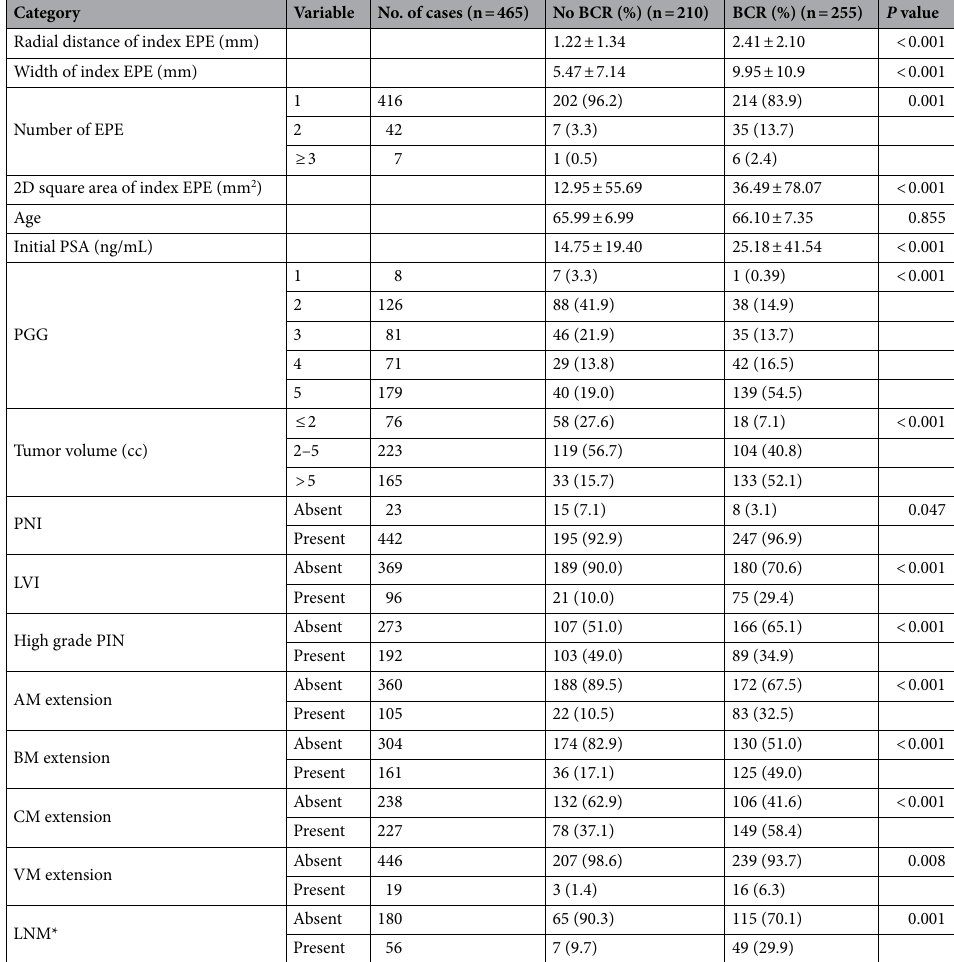
Table 1. Demographic results of 465 EPE positive pT3a cases according to BCR. BCR, biochemical recurrence; EPE, extraprostatic extension; PSA, prostate specific antigen; PGG, prostate grade group; PNI, perineural invasion; LVI, lymphovascular invasion; AM, apex margin; BM, basal margin; CM, circumferential margin; VM, vas deferens margin; LNM, lymph node metastasis. *Evaluated in 236